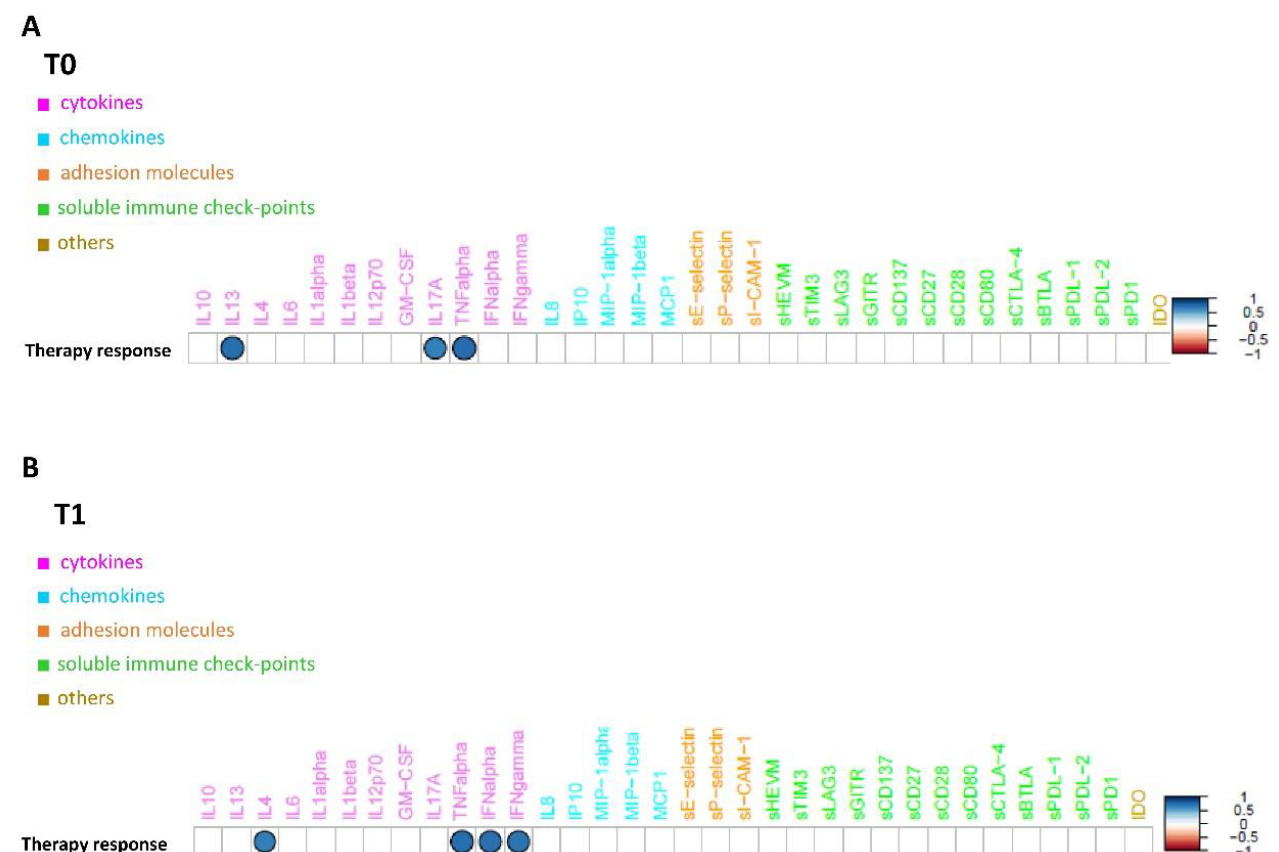
Figure 3. Connectivity map between molecules’ profiles and therapy response values at T0 ( A ) and at T1 ( B ). Statistically significant Spearman correlations ( p -value ≤ 0.05) are reported. In the plot, circles are scaled and colored according to the correlation values, increasing from red (negative correlation) to blue (positive correlation). Molecules are grouped and ordered according to the functional group reported in the legend.